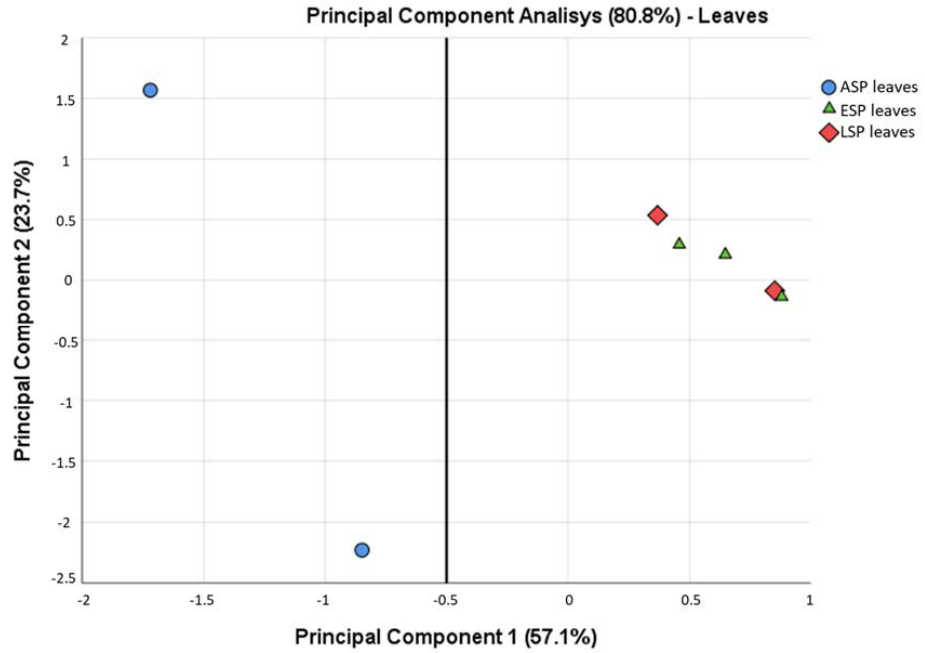
Figure 9. Principal Component Analysis calculated among the leaf samples, based on the relative abundance of OTUs in each family. The line was added to highlight the separation between the ASP leaf samples and the ESP/LSP leaf samples.